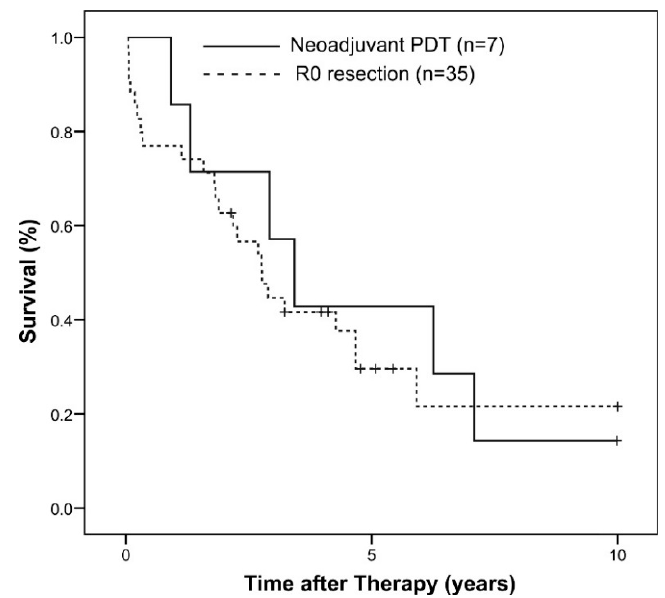
Figure 1. Kaplan-Meier estimation of patient survival: The survival curve of the patients resected R0 after neoadjuvant PDT ( n = 7) compared with the survival curve reported for the historical cohort of patients ( n = 35) resected R0 without pre-treatment ([20], p = 0.34, log rank test). Individual patients still alive during follow-up are indicated by marks on the curves. Reprinted by permission of Wolters Kluwer Health [20]—promotional and commercial use of the material in print, digital or mobile device format is prohibited without the permission from the publisher Wolters Kluwer Health.